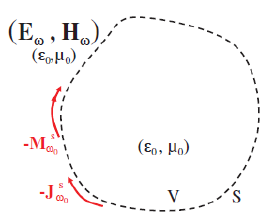
Figure 3: External Equivalence Principle Since tangential fields on surface are continuous, internal and external equivalence equations are written and matched at the boundary. The internal equivalence parts taken from these integral equations are calculated just once by using SFIE since sources radiate at 𝜔 0